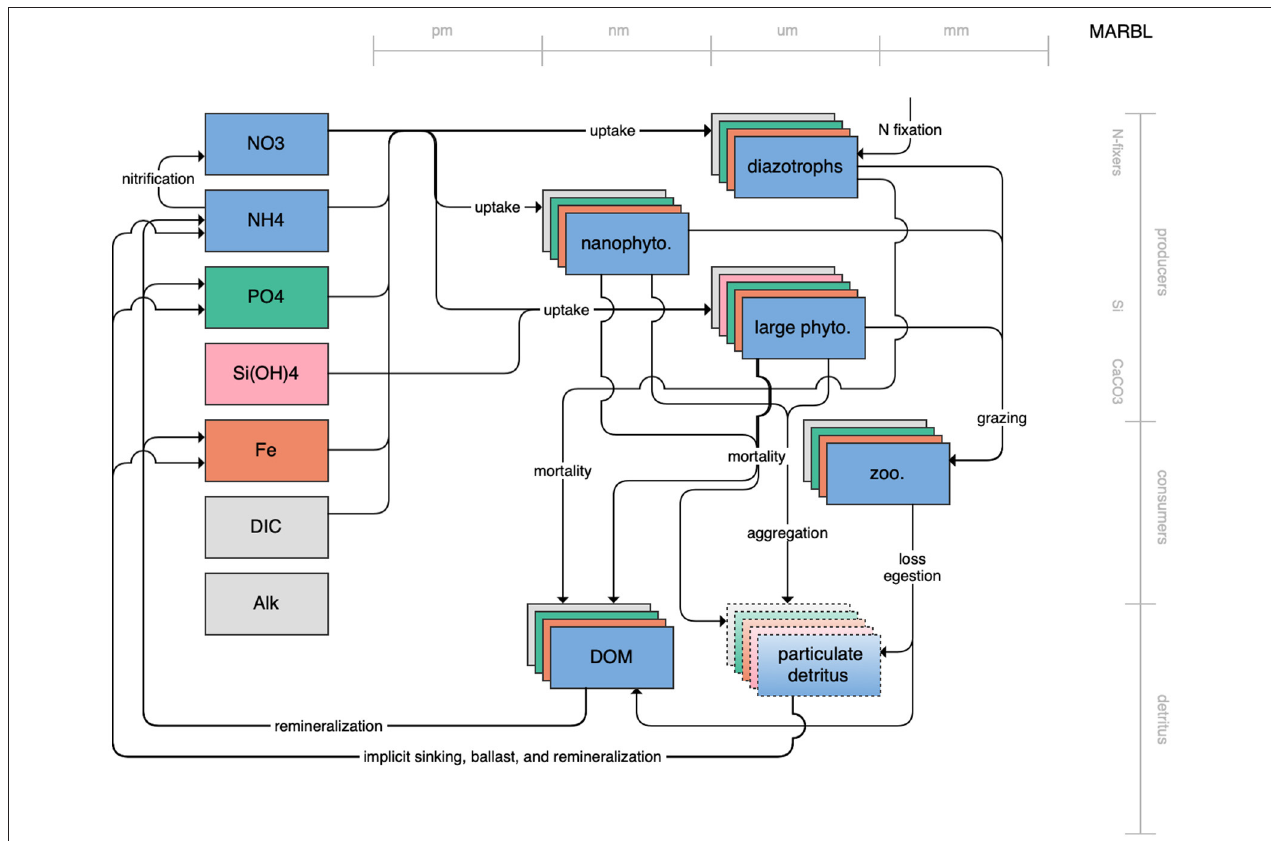
FIGURE 12 | Schematic for the MARBL model. See Figure 1 caption for